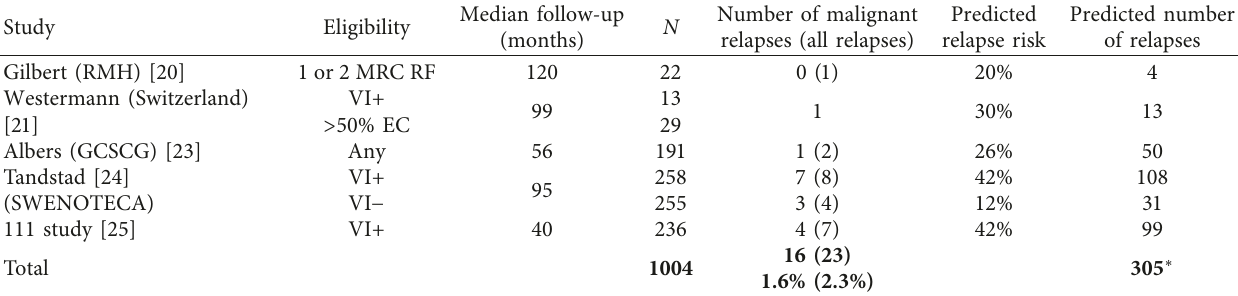
Table 3: Summary of studies of single-cycle adjuvant BEP